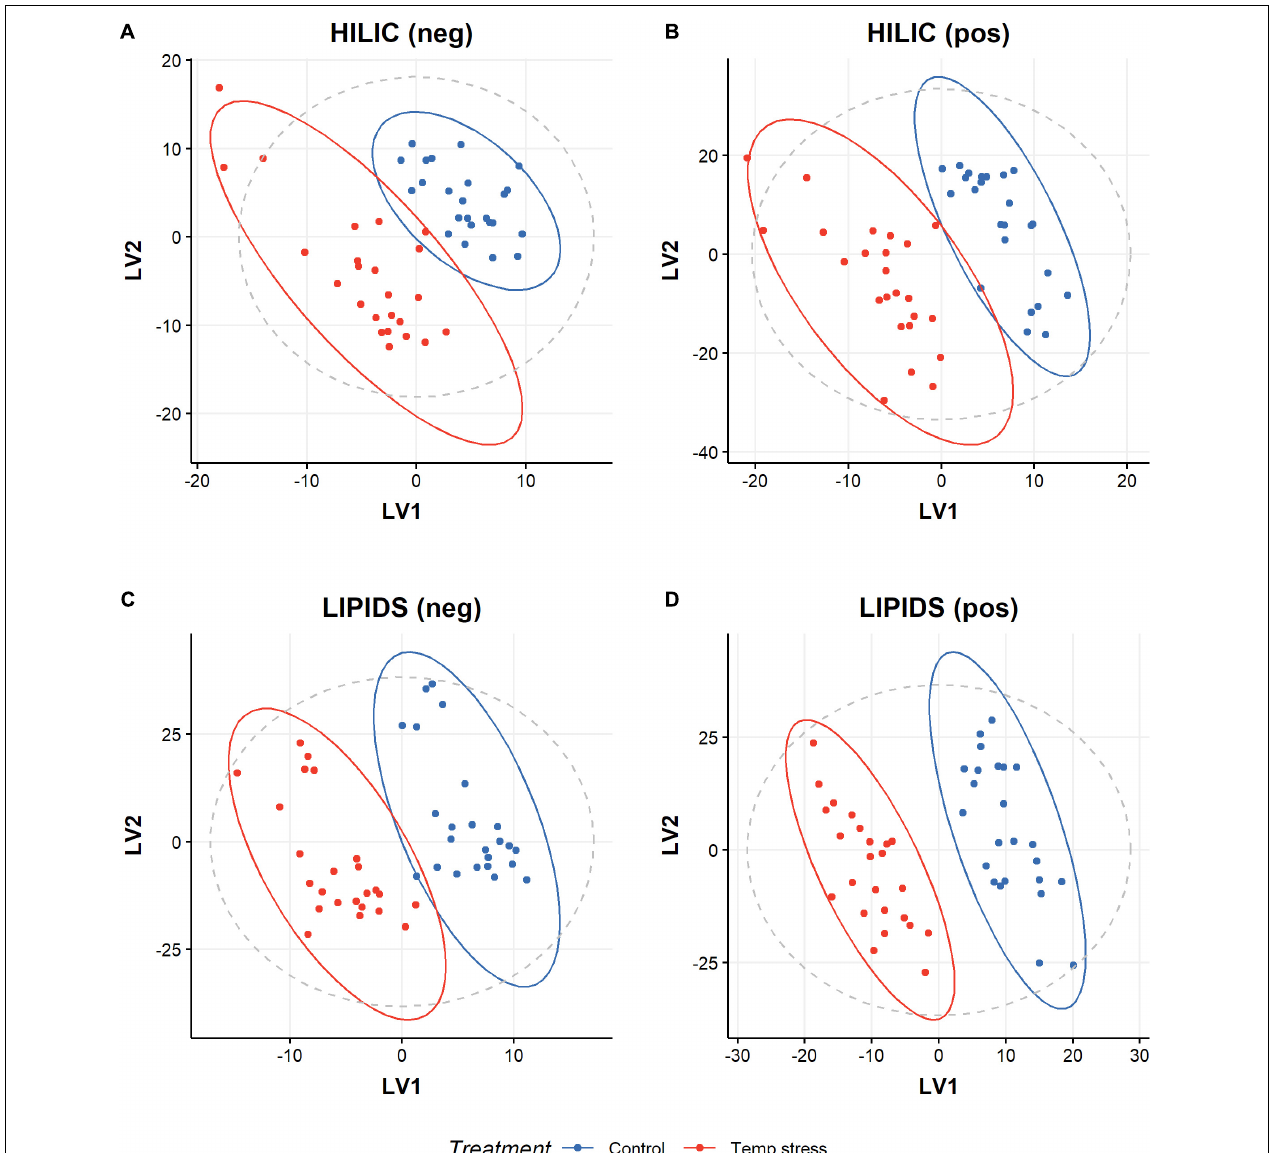
FIGURE 4 | Distribution of metabolomic profiles of A. hyacinthus and A. millepora exposed to control or acute temperature stress (8 days at 30.75 ◦ C) represented by PLSDA scores. Distribution of polar HILIC coral extracts in (A) negative mode and (B) positive mode LC-MS, and of non-polar LIPID coral extracts in (C) negative mode and (D) positive mode